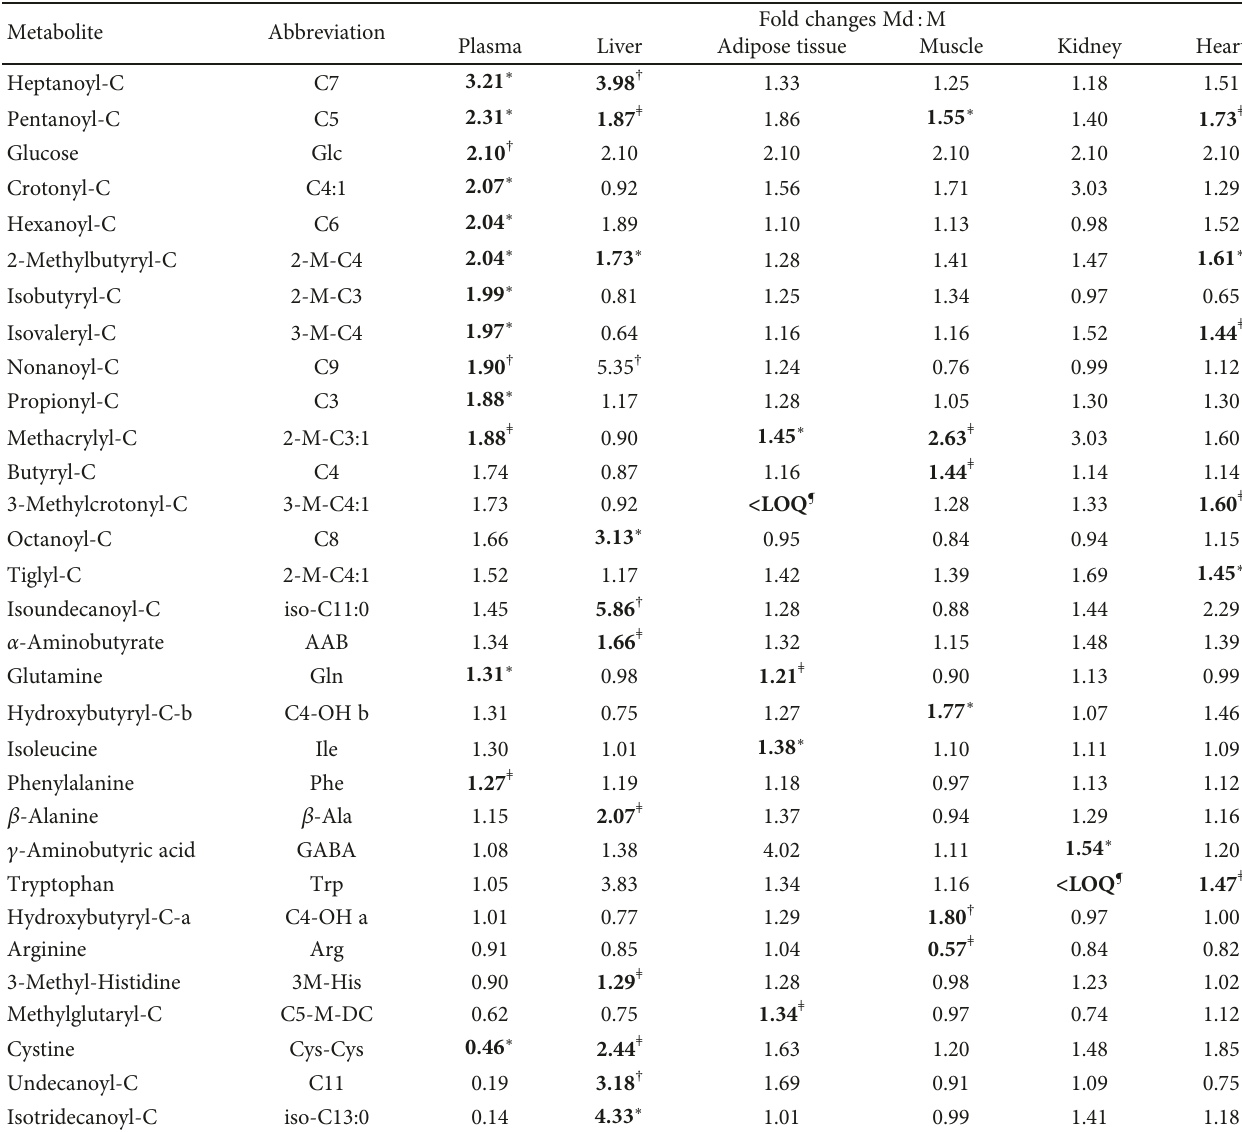
Di ff erences in plasma- and tissue-derived ACs and AAs between diabetic male NZO mice (Md) and non-/prediabetic male mice (M). Metabolites with p values above 0.05 are shown since the study aims for a holistic approach to de fi ne metabolite pro fi les for diabetic conditions rather than identifying single markers for T2DM.Results were considered as signi fi cant at athreshold of α < 0 05 . LOQ= limitof quanti fi cation; C= carnitine. ¶ < LOQ; † 0.001 < p < 0 01 ; ∗ 0.01 < p < 0 05 ; and ǂ 0.05 < p < 0 1